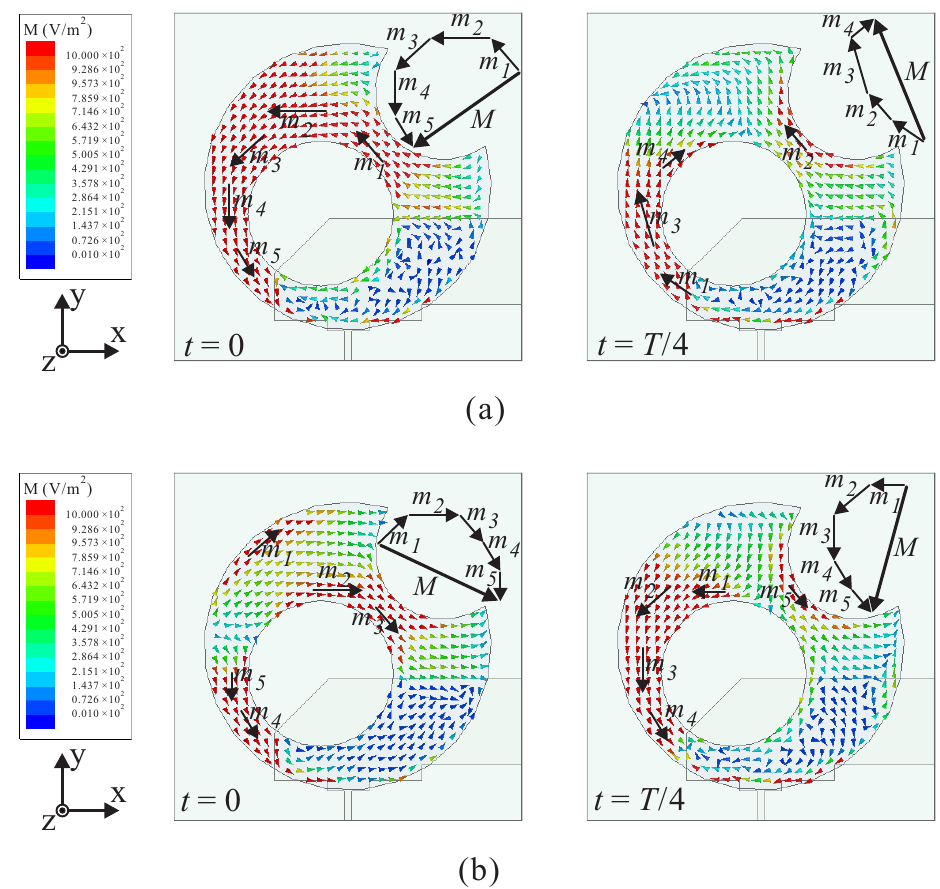
Figure 5. Simulated electric-field distributions in the slot with period T at: ( a ) 2.1 GHz; ( b ) 3.5